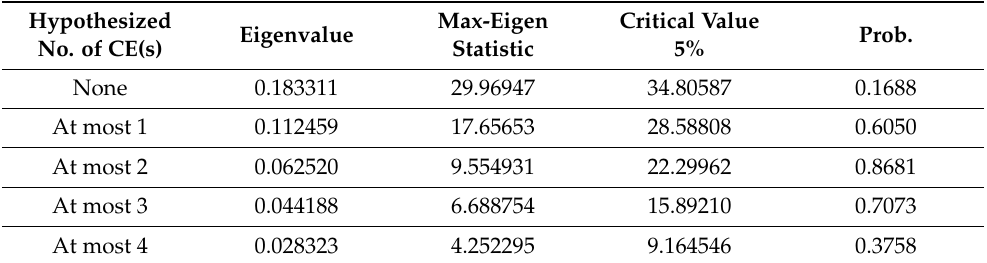
Table 7. Max eigenvalue—Johansen cointegration method (pre-vaccine period).